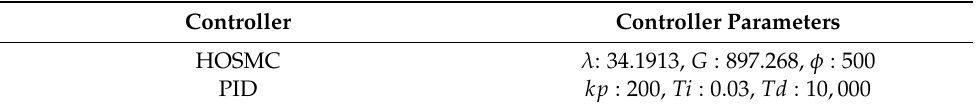
Table 7. Parameter configurations of the controller of the fixed moment of inertia.